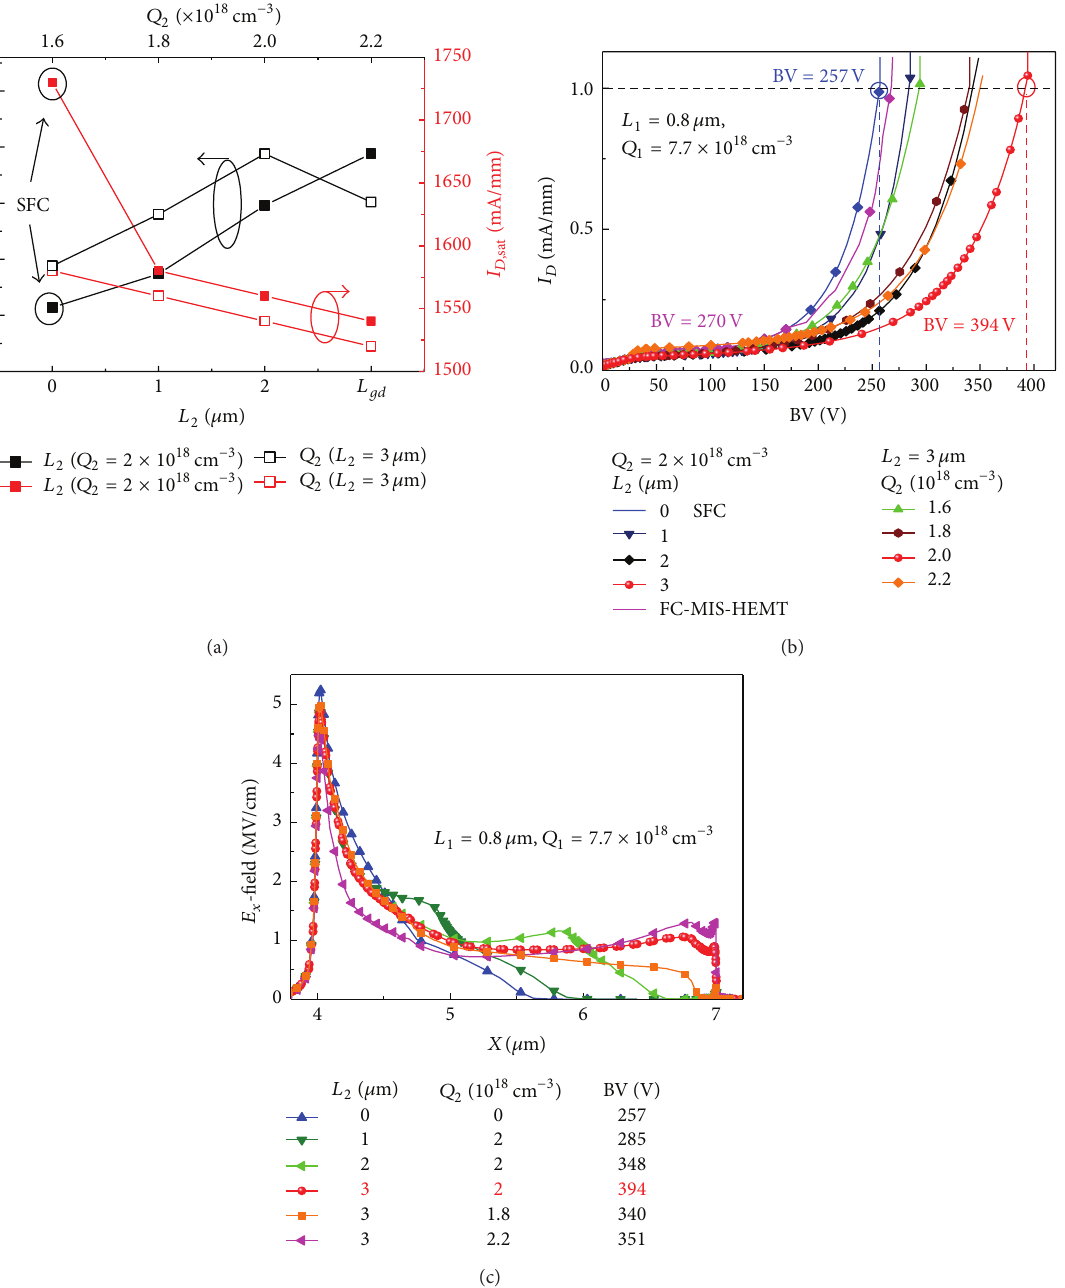
Figure 4: (a) Influences of 𝐿 2 and 𝑄 2 on BV and 𝐼 𝐷, ; (b) 𝐼 - 𝑉 curves for the different 𝐿 2 and 𝑄 2 values, where the BV is defined as the sat source-drain voltage at 𝐼 𝐷 = 1 mA/mm and 𝑉 𝑔 = 0V; (c) 𝐸 𝑥 -field at AlGaN/GaN